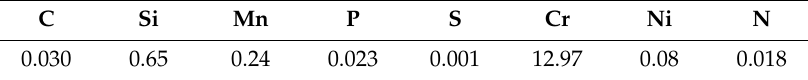
Table 1. Chemical compositions of experimental